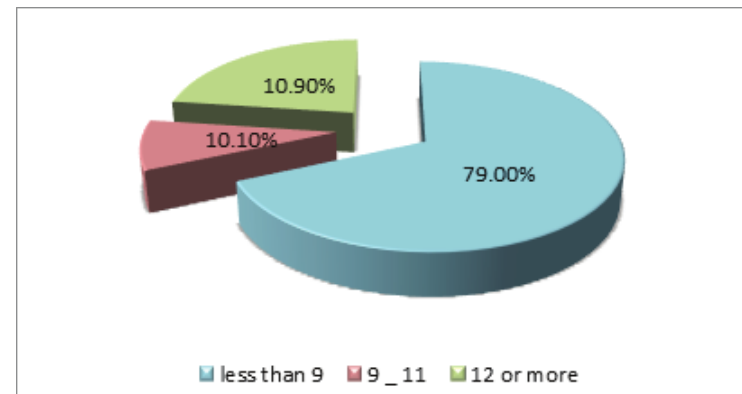
Figure 2: Percentages of mothers’ EPDS points screened for PPD, at the Saad Abueleella and Dream International Hospitals; n =